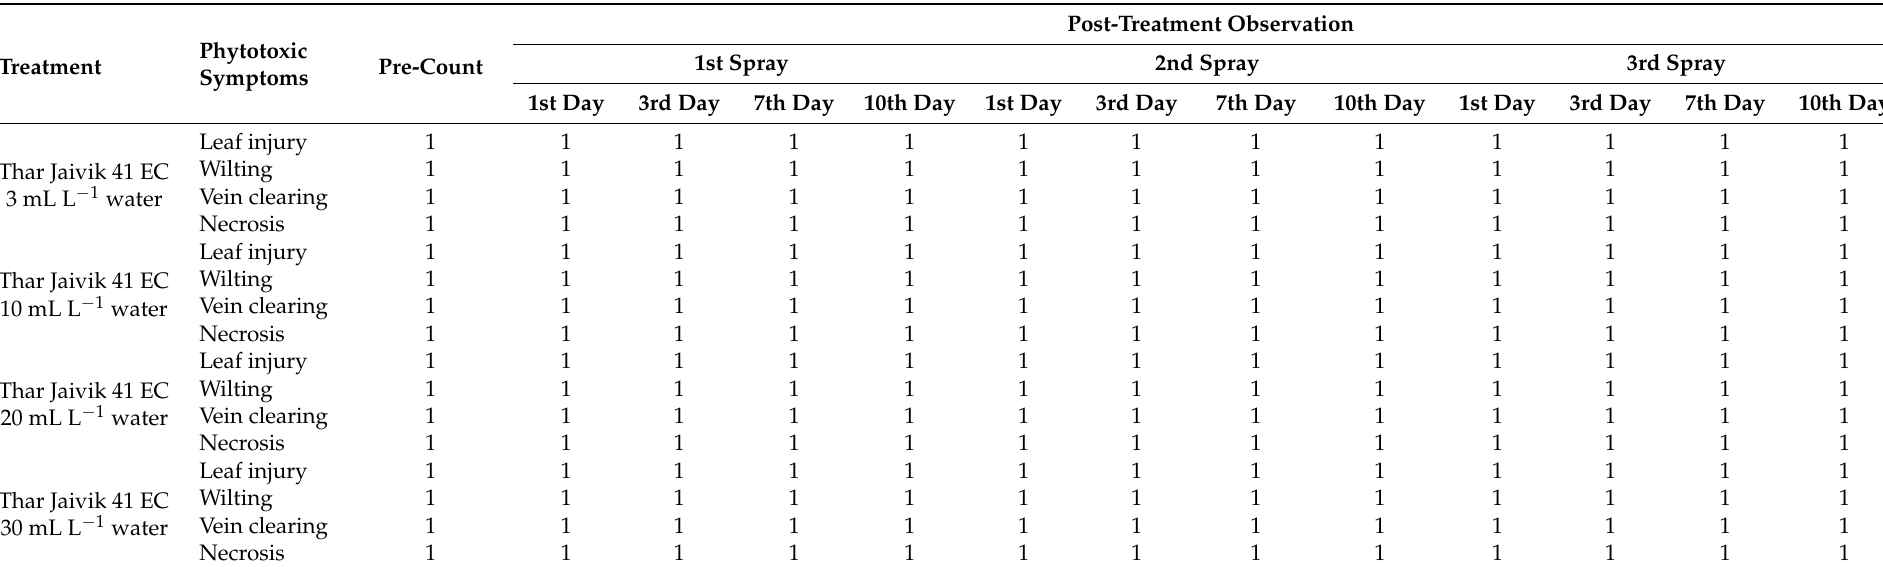
Table 5. Phytotoxic effect of different concentrations of “Thar Jaivik 41 EC” on cucurbit plants (snap melon, muskmelon and